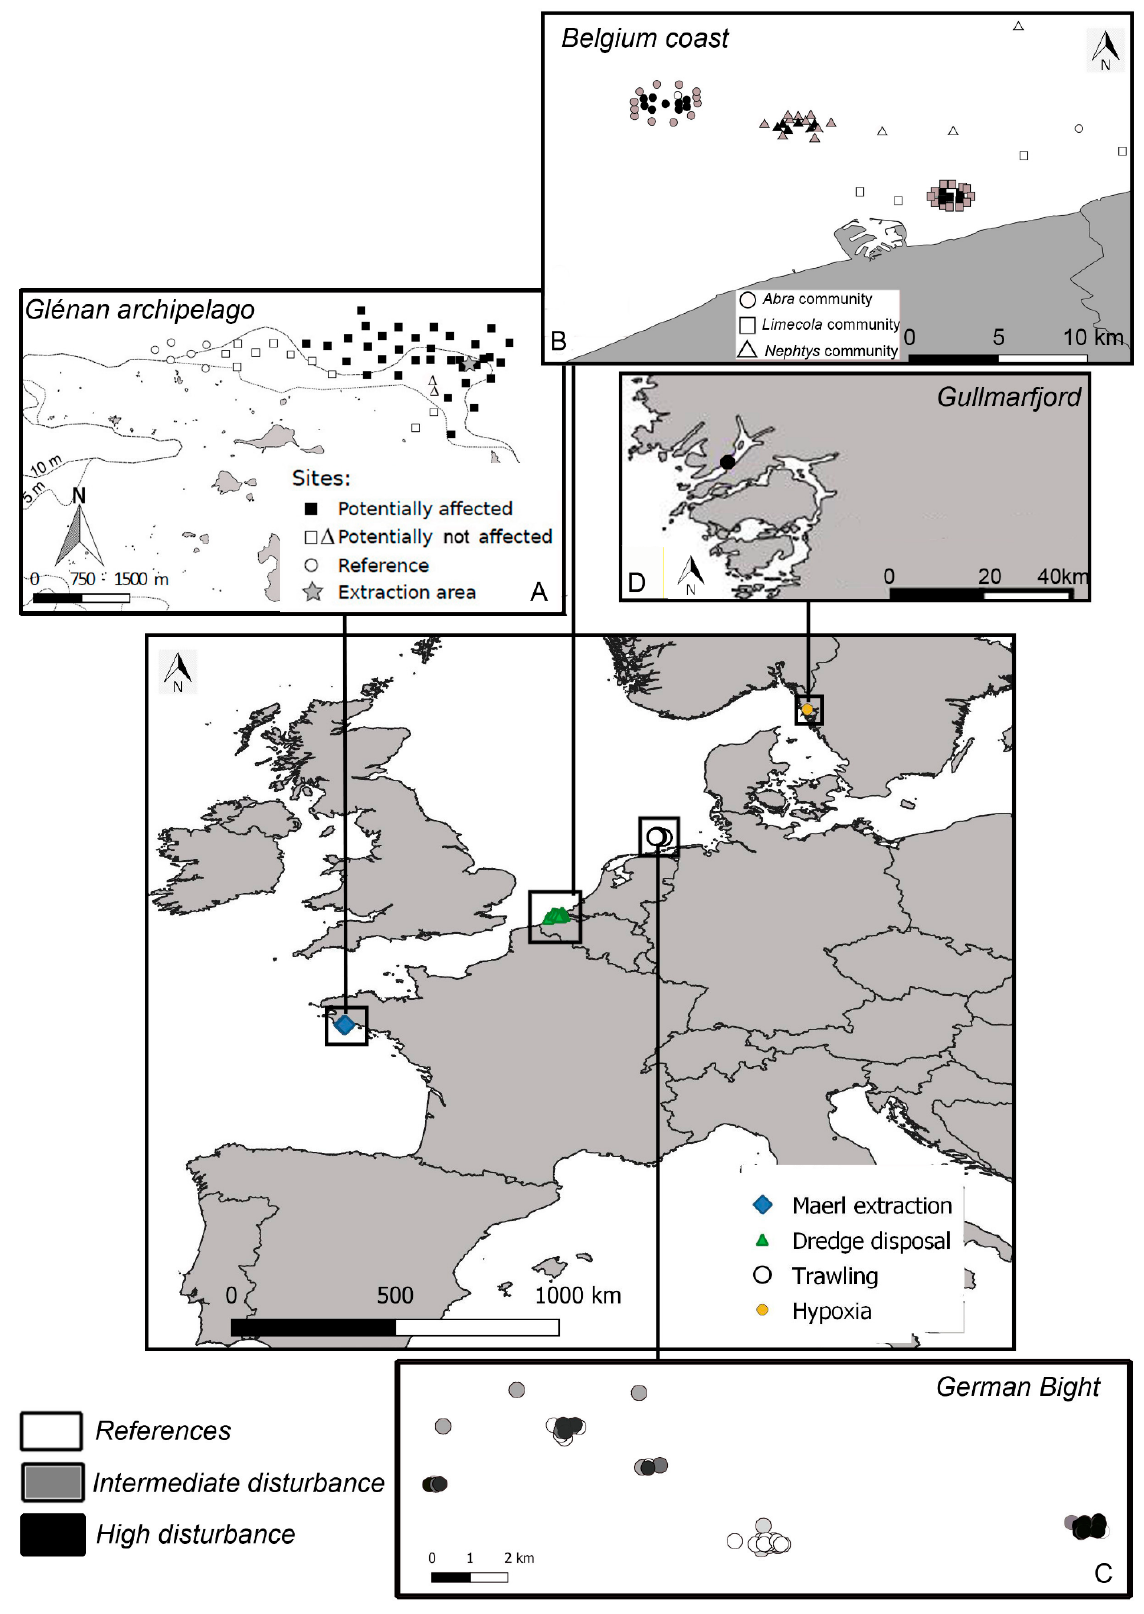
Figure 1. Map showing the locations of the 4 case studies: ( A ) maerl extraction in the Glénan Archipelago, ( B ) dredging on the Belgium coast, ( C ) trawling in the German Bight (North Sea) ( D ), and the station submitted to hypoxia in the Gullmarfjord.